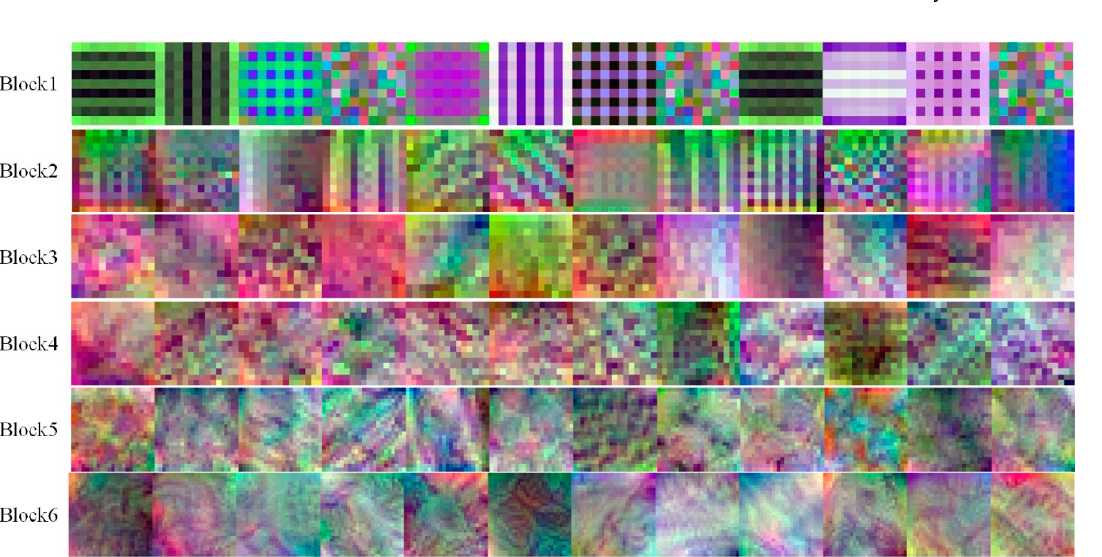
15 of 20 Figure 13. Detection results of IRM-YOLOv2 detector. 3.3. Visualization of Convolution Layers The CNN model utilizes different convolution learning objective characteristics in the training process, which determine the final accuracy. Visualizing the features learned by the CNN during the training process will clarify the learning content of the different